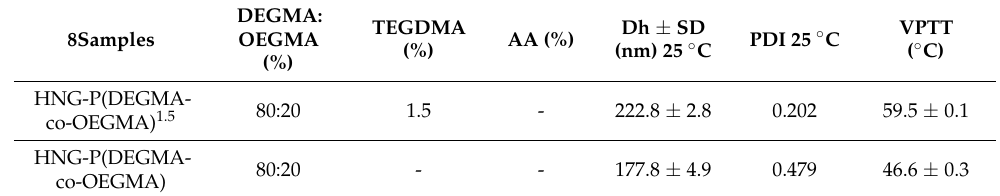
Table 2. HNGs synthesized starting from constant amount of MSN@MEMO DEGMA:OEGMA 80:20 with/without TEGDMA and